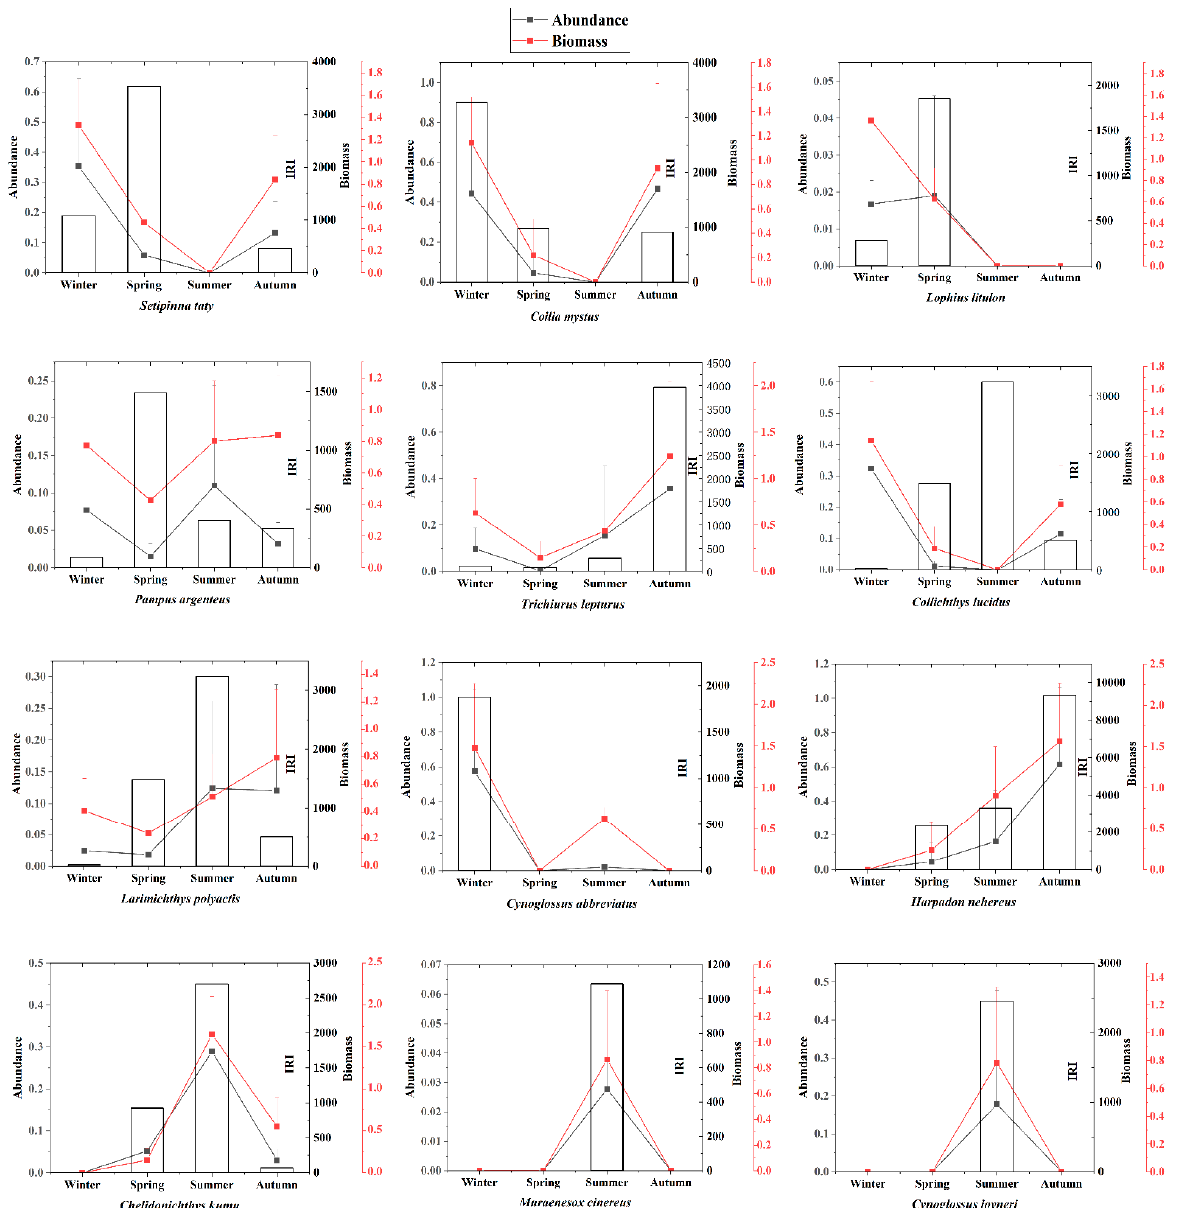
Figure 6. Seasonal distribution of dominant fish species with IRI > 1000: abundance (kN/km 2 ), biomass (kg/km 2 ), where error bars indicate standard deviations.